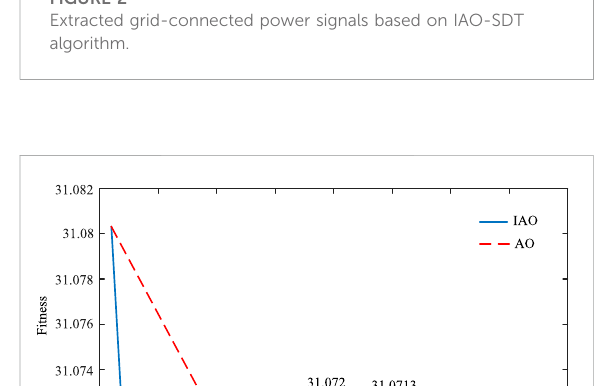
FIGURE 2 Extracted grid-connected power signals based on IAO-SDT algorithm.